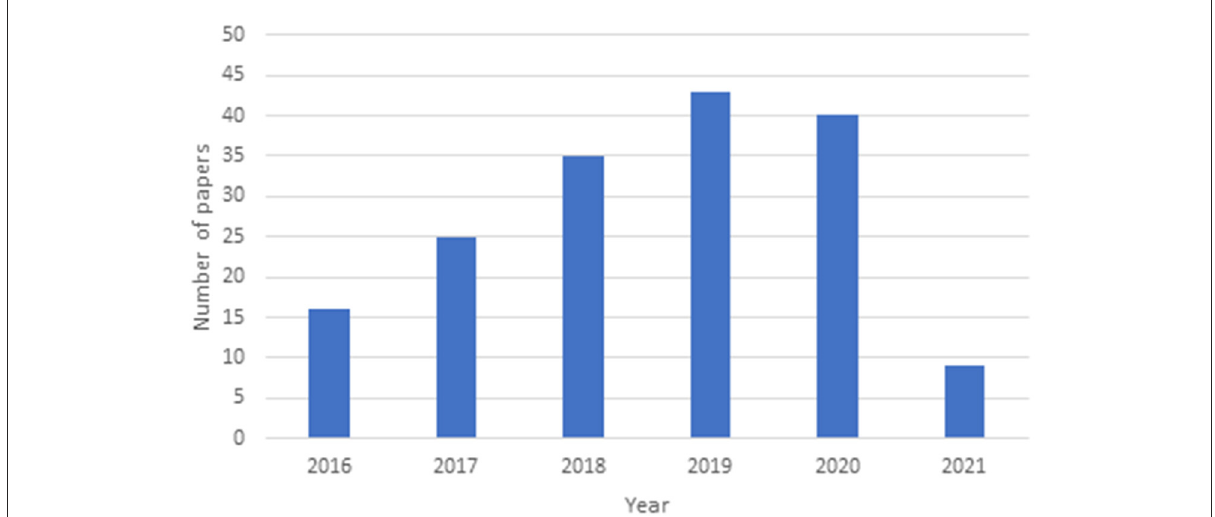
FIGURE3 Geographic distribution of gender research in agricultural and pastoral livelihoods in target countries.